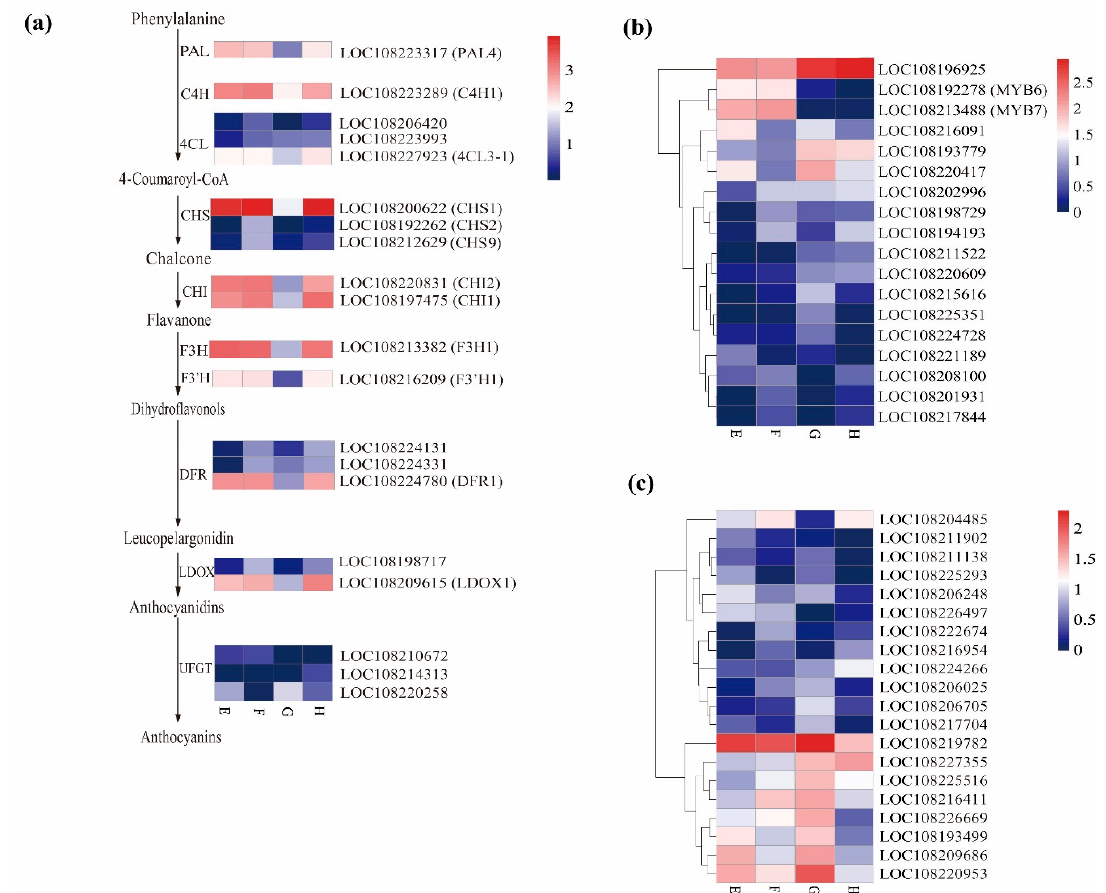
Figure 3. Expression pattern of differently expressed genes (DEGs) involved in anthocyanin synthesis. ( a ) Expression pattern of structural genes involved in anthocyanin synthesis. ( b ) Expression pattern of MYB involved in the different tissues. ( c ) Expression pattern of bHLH involved in the different tissues. The value of log10 (FPKM + 1) is represented by the depth of color, with red representing upregulation and blue representing downregulation. PAL, phenylalanine ammonia-lyase; C4H, cinnamate 4-hydroxylase; 4CL, 4-coumarate-CoA ligase; CHS, chalcone synthase; CHI, chalcone isomerase; F3H, flavonoid 3 hydroxylase; F3 ′ H, flavonol 3 ′ hydroxylase; DFR, dihydroflavonol 4-reductase; LAR, leucoanthocyanidin reductase; UFGT, UDP glucose: flavonoid-O-glucosyltransferase. E (xylem of ‘Purple 68 ′ ), F (phloem of ‘Purple 68 ′ ), G (xylem of ‘Purple Haze’) and H (phloem of ‘Purple